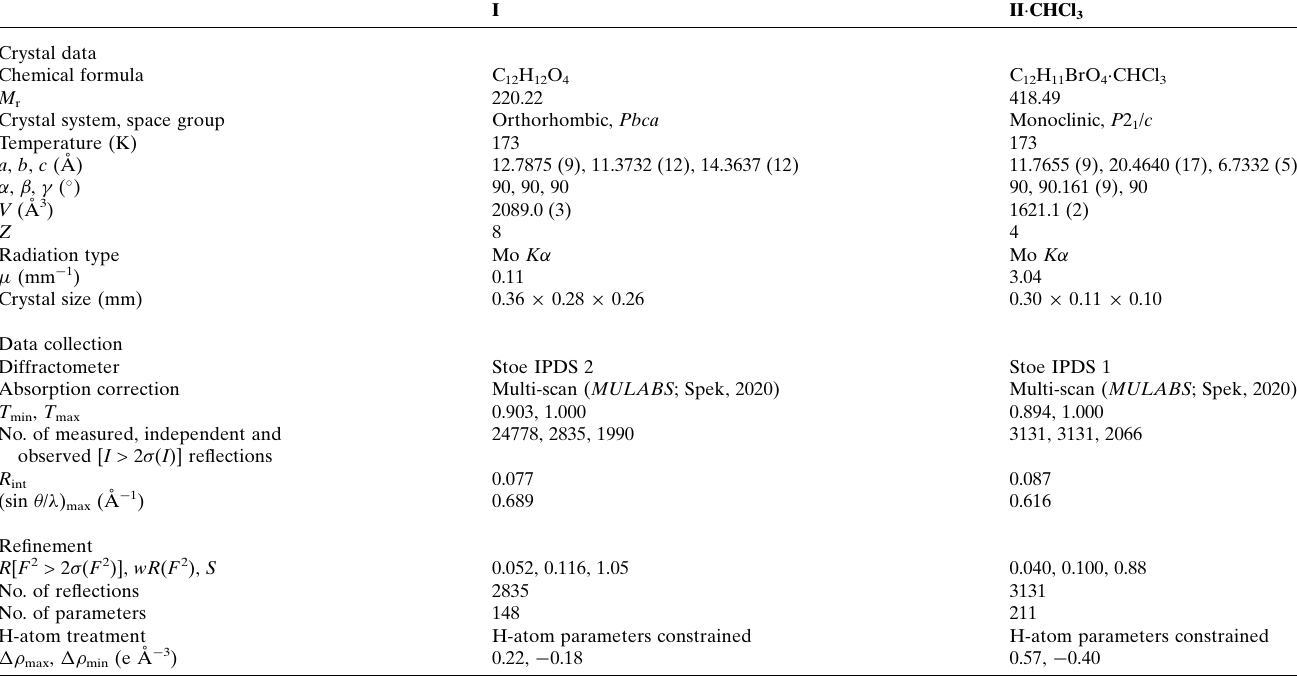
Crystal data Chemical